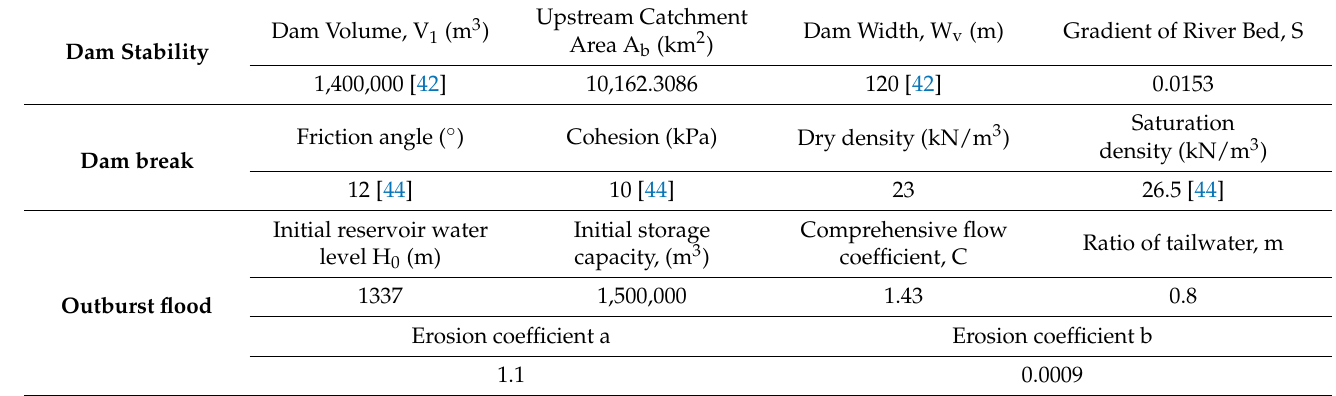
Figure 6. Analysis flow chart of barrier dam failure. DBS-IWHR and DB-IWHR are the abbreviations of China Institute of Water Resources and Hydropower Research’s Dam Breach Slope and China Insti- tute of Water Resources and Hydropower Research’s Dam Breach, respectively. HEC-RAS represents Hydrologic Engineering Center’s River Analysis System. DEM stands for Digital Elevation Model. Table 1. Geometric and material parameters of the barrier dam in the study area a)